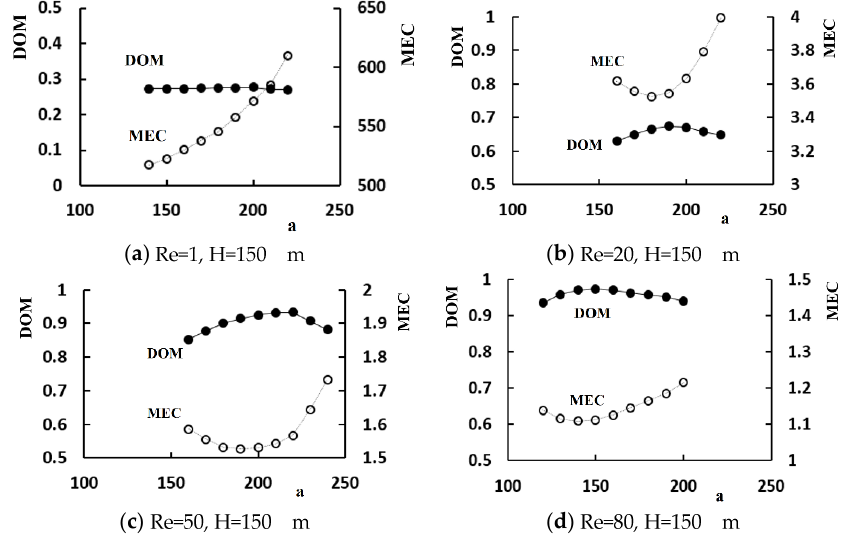
Figure 9. Variation of the DOM and MEC with the control parameter, a .